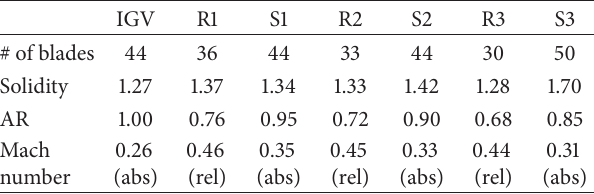
Table 1: The Purdue 3-Stage Compressor design airfoil